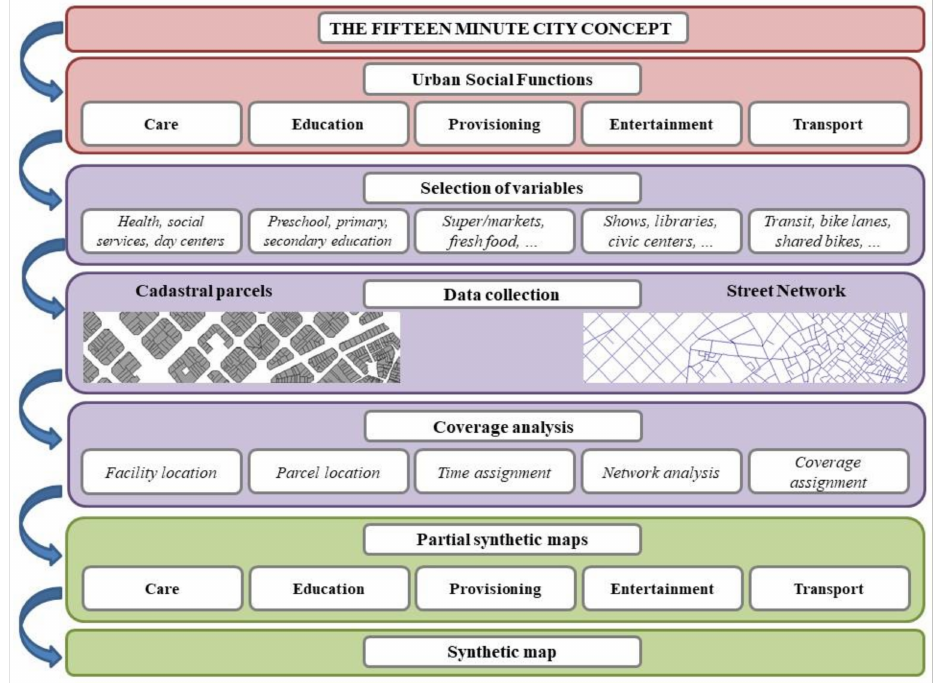
Figure 2. The proposed methodological approach. Source: own elaboration based on data from Open Data BCN